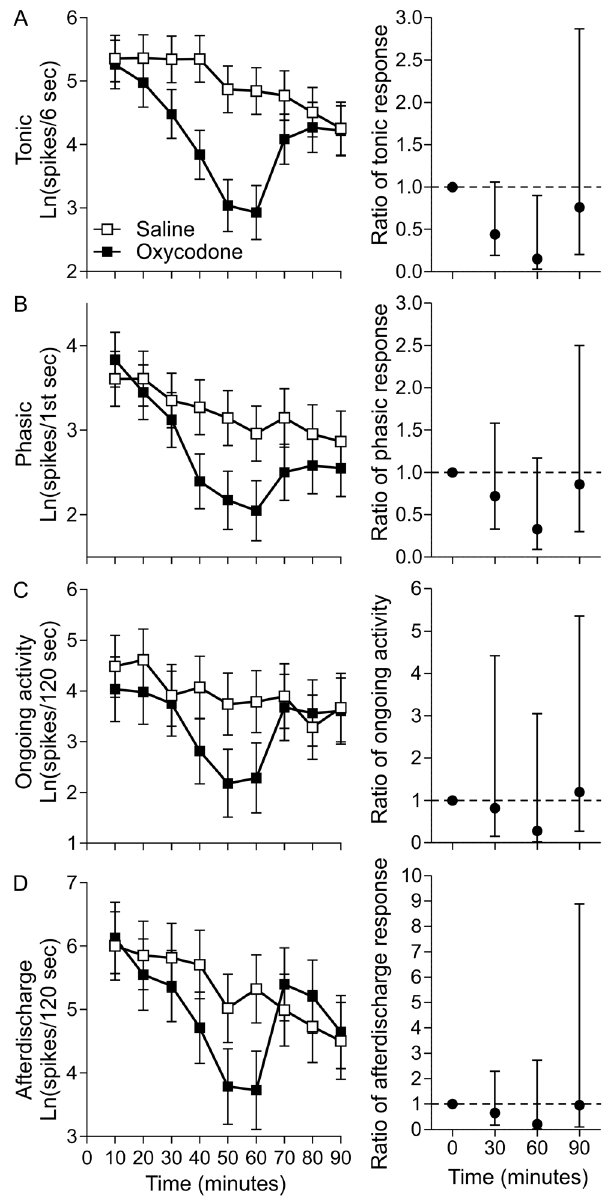
Figure 3. Effects of oxycodone on spinal dorsal horn neuronal activity. Each row shows the results for an exploratory endpoint with ANCOVA adjusted means on the left (error bars 6 sem) and the ratios of adjusted means for oxycodone/saline on the right (error bars 6 95%CI). Ratio graphs focus on 0, 30, 60 and 90 minutes, the time points at which a following cohort of animals was determined to have (mean 6 sem) 0 6 0 nM, 44 6 6 nM, 217 6 24 nM and 70 6 12 nM free plasma concen- tration of oxycodone respectively. The 90 minute time point is after a 30 minute infusion of 20 mg/kg/hr naloxone with no oxycodone infused. (A) tonic spike count during the six seconds following phasic spiking (B) phasic spiking during the first one second after rotation onset (C) ongoing activity quantified during the 120 seconds preceding each stimulus set (D) afterdischarge during the 120 seconds following the last rotation of each